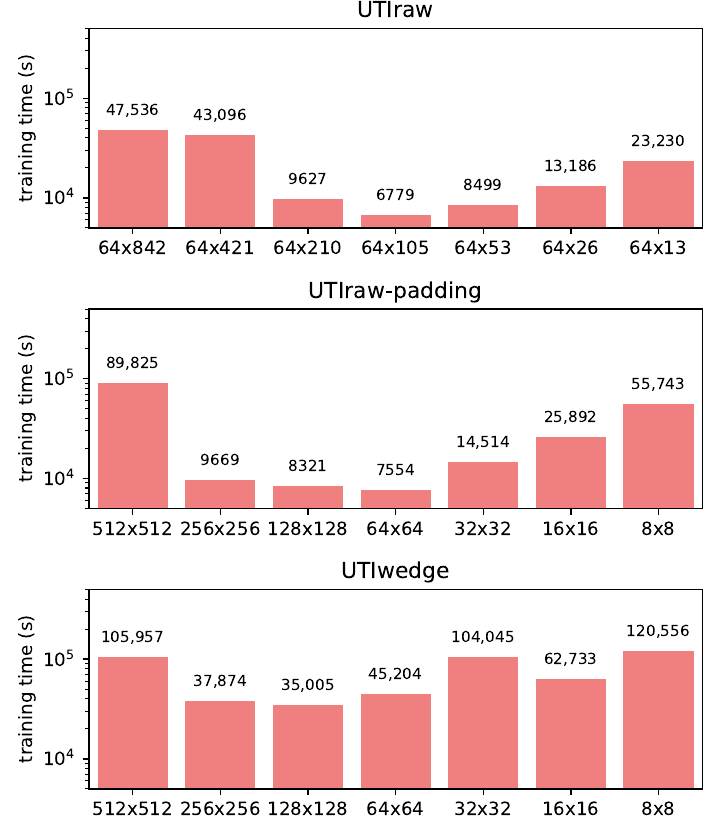
Figure 6. ResNet-50 wall-clock training time (in seconds) as a function of image